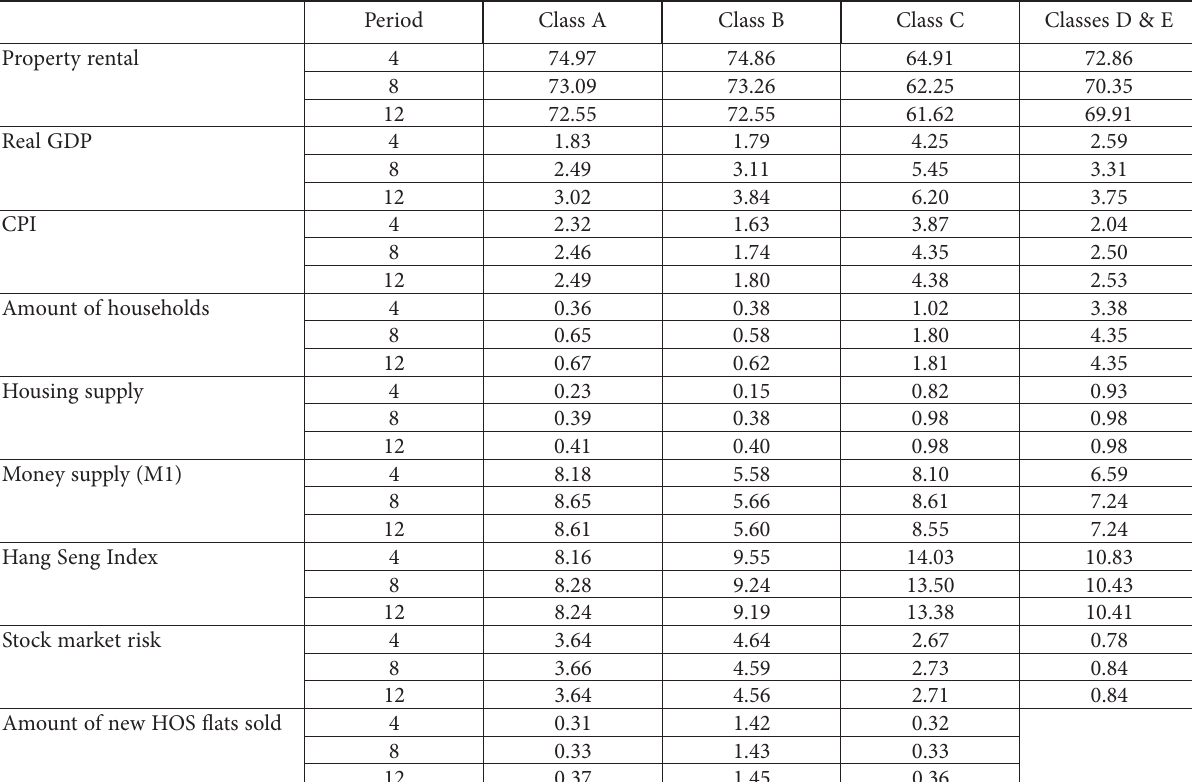
Table 4. Variance decomposition analysis results (Property rental indices; in